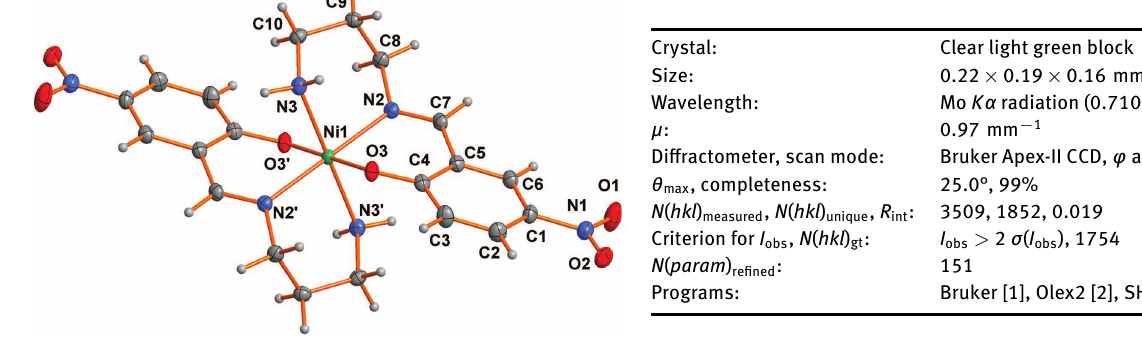
Table 2: Fractional atomic coordinates and isotropic or